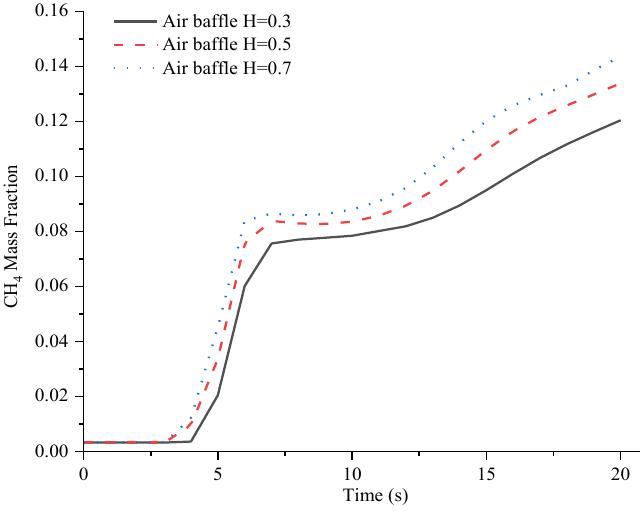
Figure 6. Effect of air baffles at different heights .